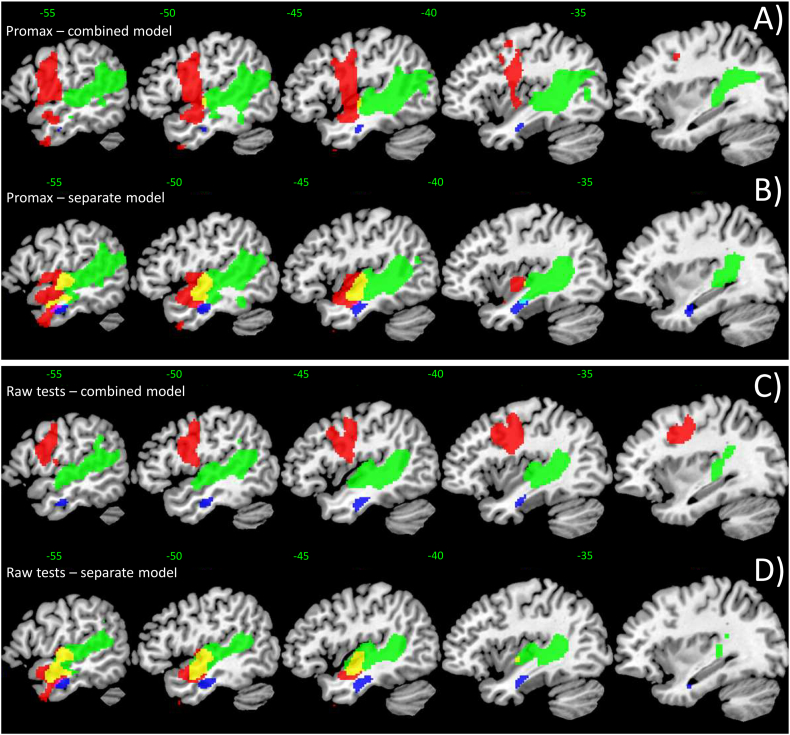
Additional analyses on the relationship of lesions and behavioural data. Factors scores from an oblique (promax rotation) principal component analysis (PCA) solution when (A) all variables are entered simultaneously into one General Linear Model, or when (B) a separate model is created for each component; and factor scores from varimax PCA when key behavioural tests (max loadings) are used (C) in a combined or (D) in a separate model. Colour-coding (A) & (B): factor 1 (phonological ability) in red, factor 2 (semantic ability) in blue (sub-threshold), factor 3 (auditory working memory) in green, and in yellow factor 1 & 3 overlap (same colour-coding as Fig. 2D). Colour-coding (C) & (D): immediate word repetition in red, spoken word-to-picture matching in blue, and forward digit span in green. Results were generally thresholded at voxel height p < 0.005, cluster-corrected FWE p < 0.05; only the sub-threshold clusters were thresholded at voxel height p < 0.005, voxel extent k > 100.